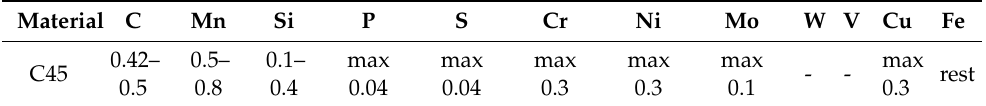
Figure 2. Photographs of: ( a ) a forging with the flash made on the analyzed press, ( b ) the results of scanning an exemplary defective forging with visible joggles—differences between the upper and lower portion of the forging.